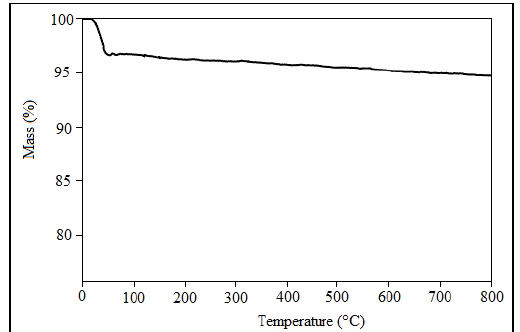
Fig. 2. The TEM image of the nano TiO